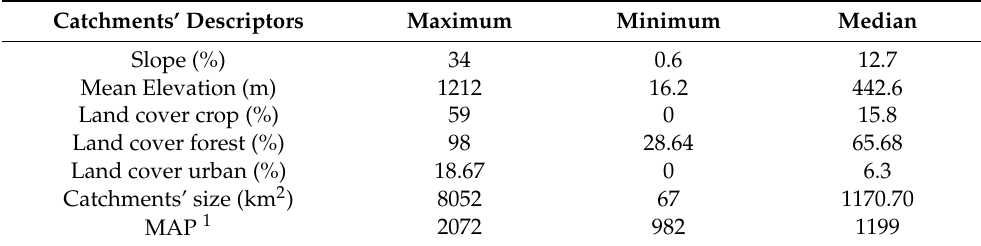
Table 1. Statistics of catchments’ descriptors used in this